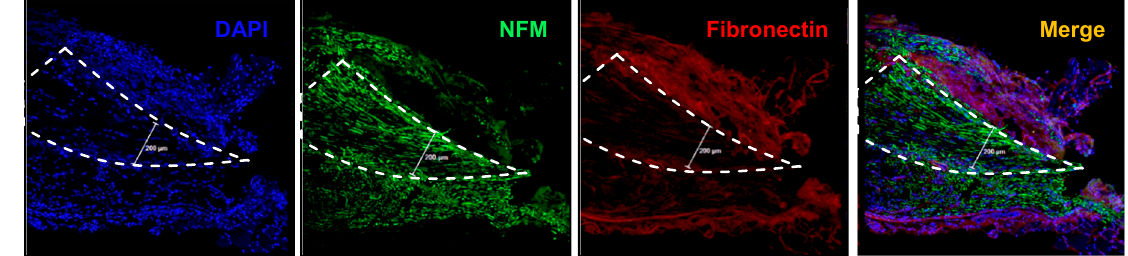
Figure 6. IHC analysis. Immunohistochemistry images of the representative longitudinal section of the sciatic nerve implanted with the neural electrode and artificial conduit.